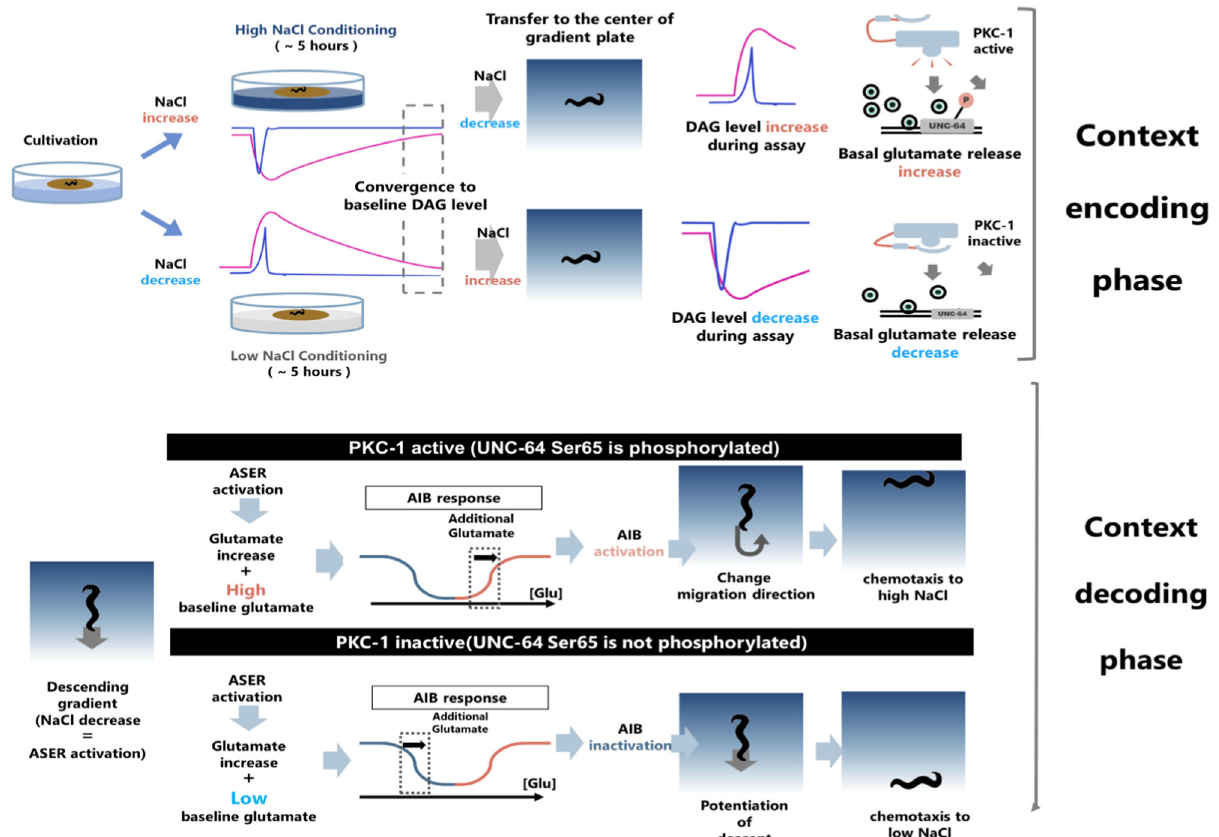
Fig. 8 Summary of the study. In the encoding phase (top), when the animals are transferred from the conditioning plates to the center of NaCl gradient in the test plate, ASER is activated or deactivated(blue line), and the amount of DAG changes (pink line, as described in Fig. S1). DAG regulates the activity of PKC-1 to alter its behavior. The activity of PKC-1 regulates the phosphorylation level of UNC-64 Ser65, thereby altering the level of baseline glutamate release from ASER. When animals move on the NaCl gradient in the decoding phase (bottom), ASER responds to the change in NaCl concentration. When worms perceive a NaCl decrease, ASER is activated, and glutamate release from ASER increases acutely. Baseline release is determined by PKC-1 activity in the encoding phase and occurred independently of this increase. When the baseline release rate is low, the highly sensitive inhibitory glutamate receptor in the AIB interneuron responds to glutamate increase (see Fig. 7). When the baseline release rate is high, the low-sensitivity excitatory glutamate receptor